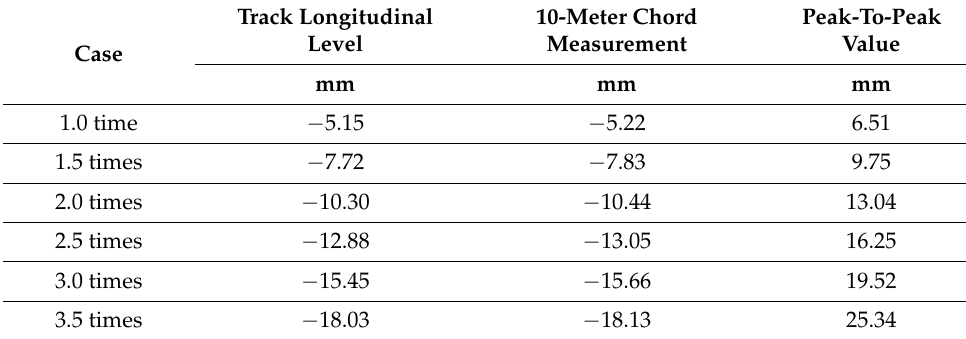
Table 2. The detail of track longitudinal